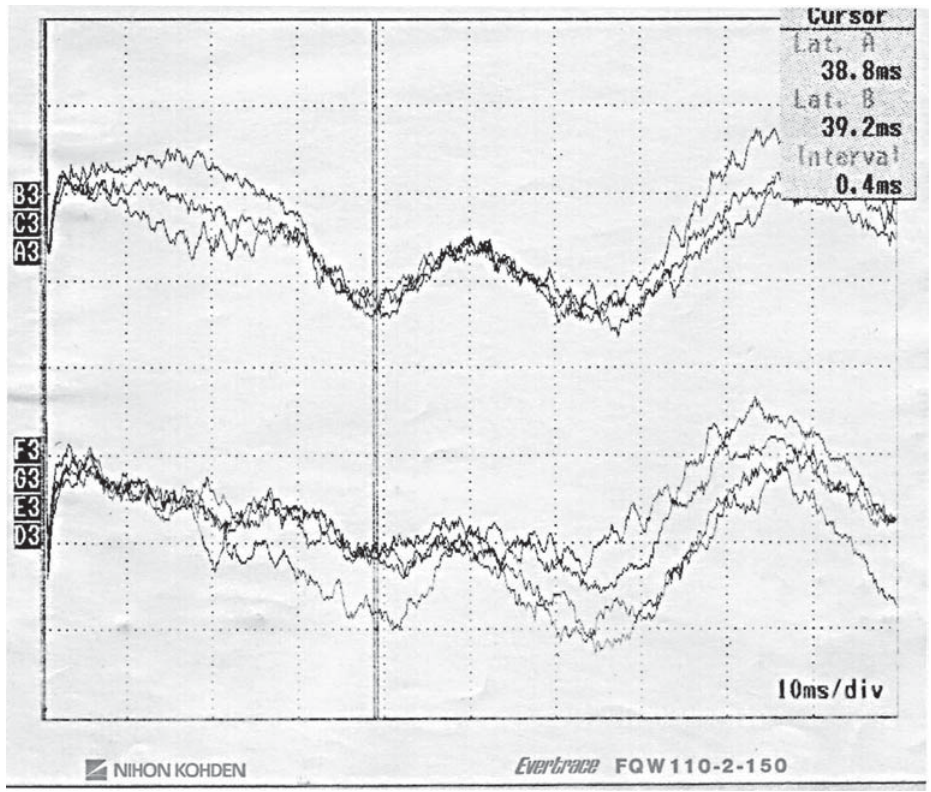
Figure 1 – Recordings of the pudendal somatosensory evoked potential obtained by left (up) and right (down) clitoral stimulation. The vertical line demonstrates the latency (P1